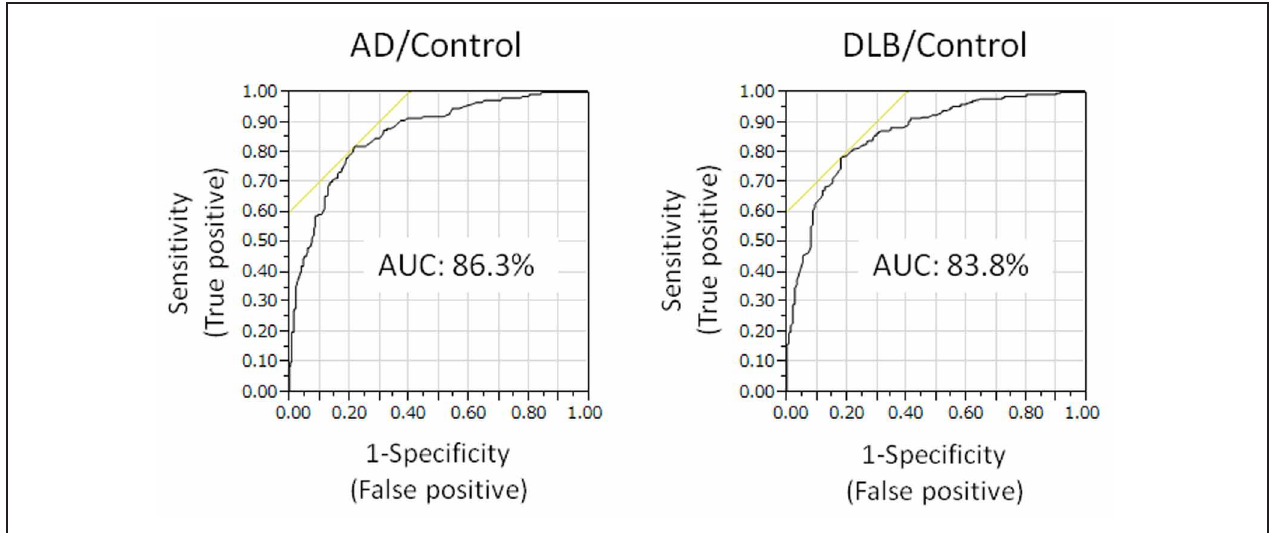
FIGURE 2 | Receiver operating characteristic (ROC) curves showing prediction of either AD or DLB by plasma annexin A5. The probability of either AD or DLB can be predicted by a logistic regression model with the